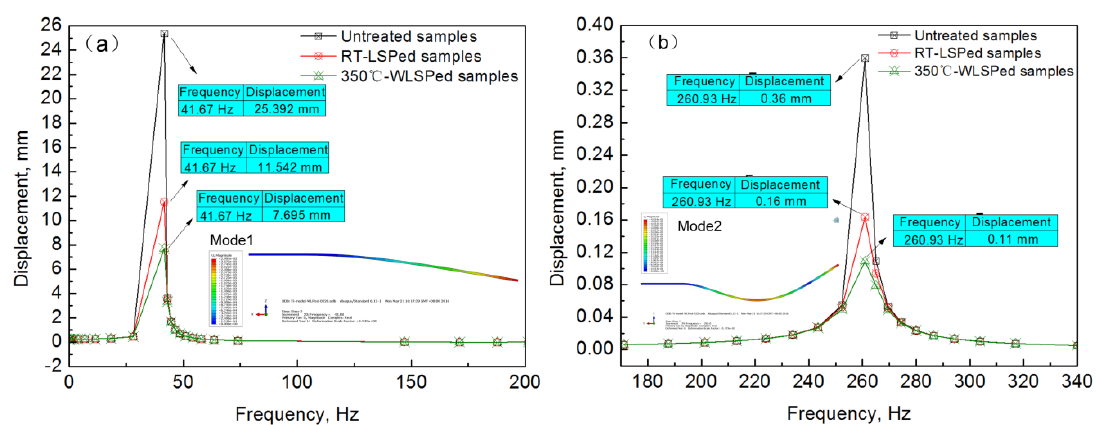
Figure 9. Frequency response process of untreated, RT-LSPed and 350 °C-WLSPed samples when the loaded pressure is 300 MPa: ( a ) Mode 1, ( b ) Mode 2.